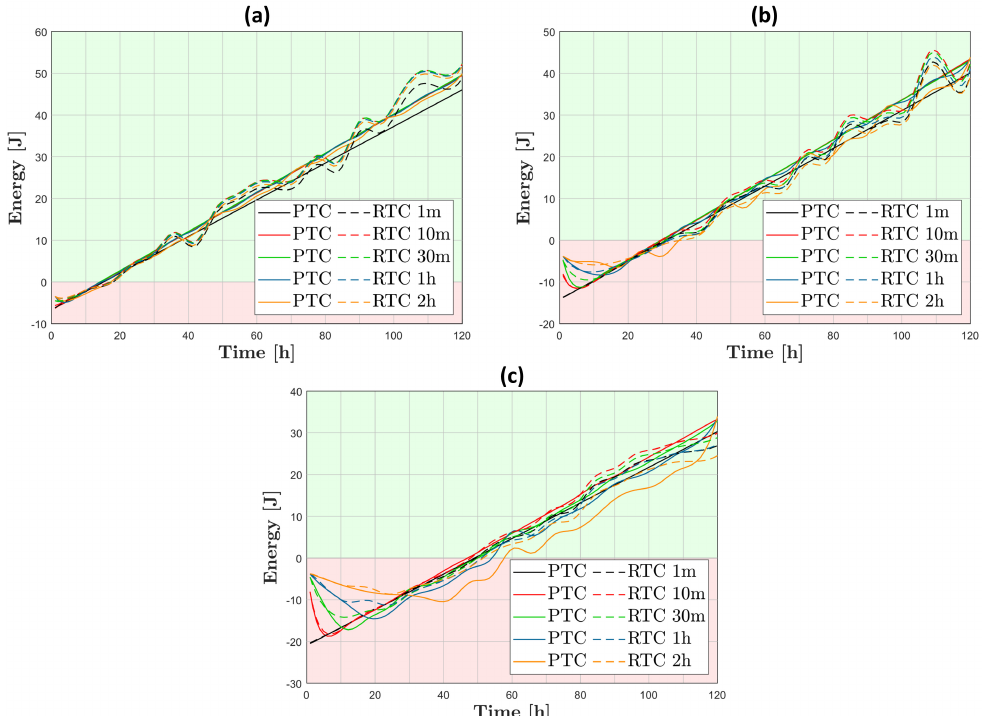
Figure 11. Average energy profile vs. simulation time for five sensing inactive times under ( a ) 4 excitations; ( b ) 12 excitations; and ( c ) 20 excitations. The behavior due to PTC and RTC is identified by the solid and dashed lines,